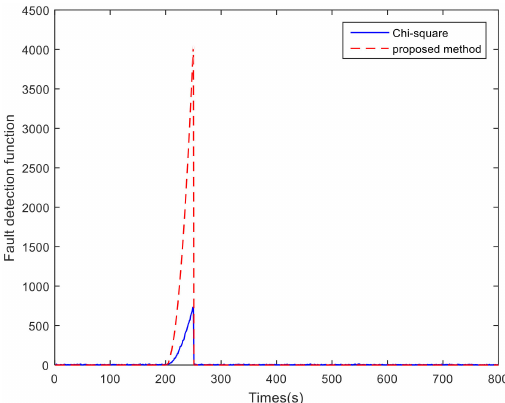
Figure 8. The test statistic of fault detection obtained by simulation under the single-satellite ramp